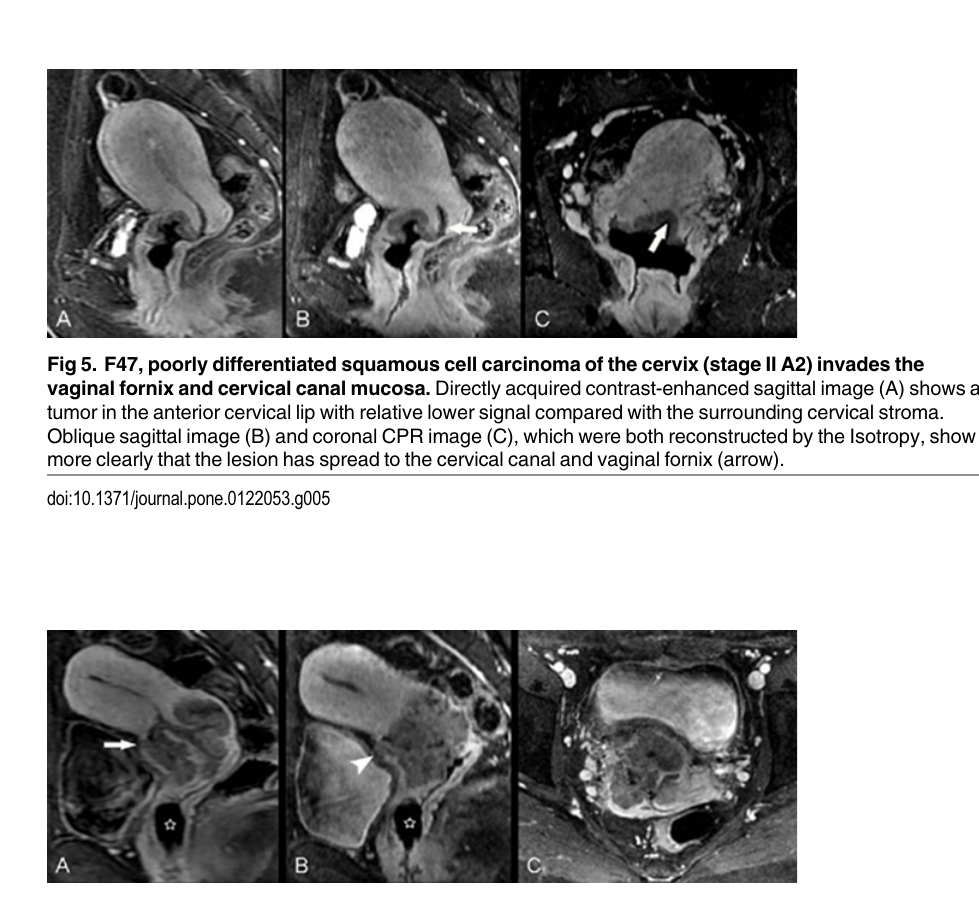
Fig 6. F28, poorly differentiated squamous cell carcinoma (stage II B) with negative cystoscopic findings. Pathology of intraoperative biopsy found cancer cells between the anterior wall of the cervix and bladder. Directly acquired contrast-enhanced sagittal image (A) shows a large cervical cancer lesion with relative lower signal compared with the surrounding cervical stroma. The anterior cervical stroma is suspicious interrupted (arrow). Sagittal image reconstructed by isotropic sequence (B) and axial isotropic image (C) clearly demonstrate that the anterior cervical stroma is interrupted by tumor (arrowhead). An OB tampons was placed inside the vagina (star).